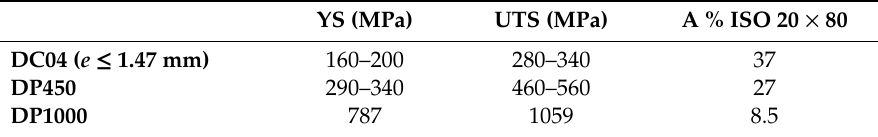
Table 4. Steel’s mechanical properties.